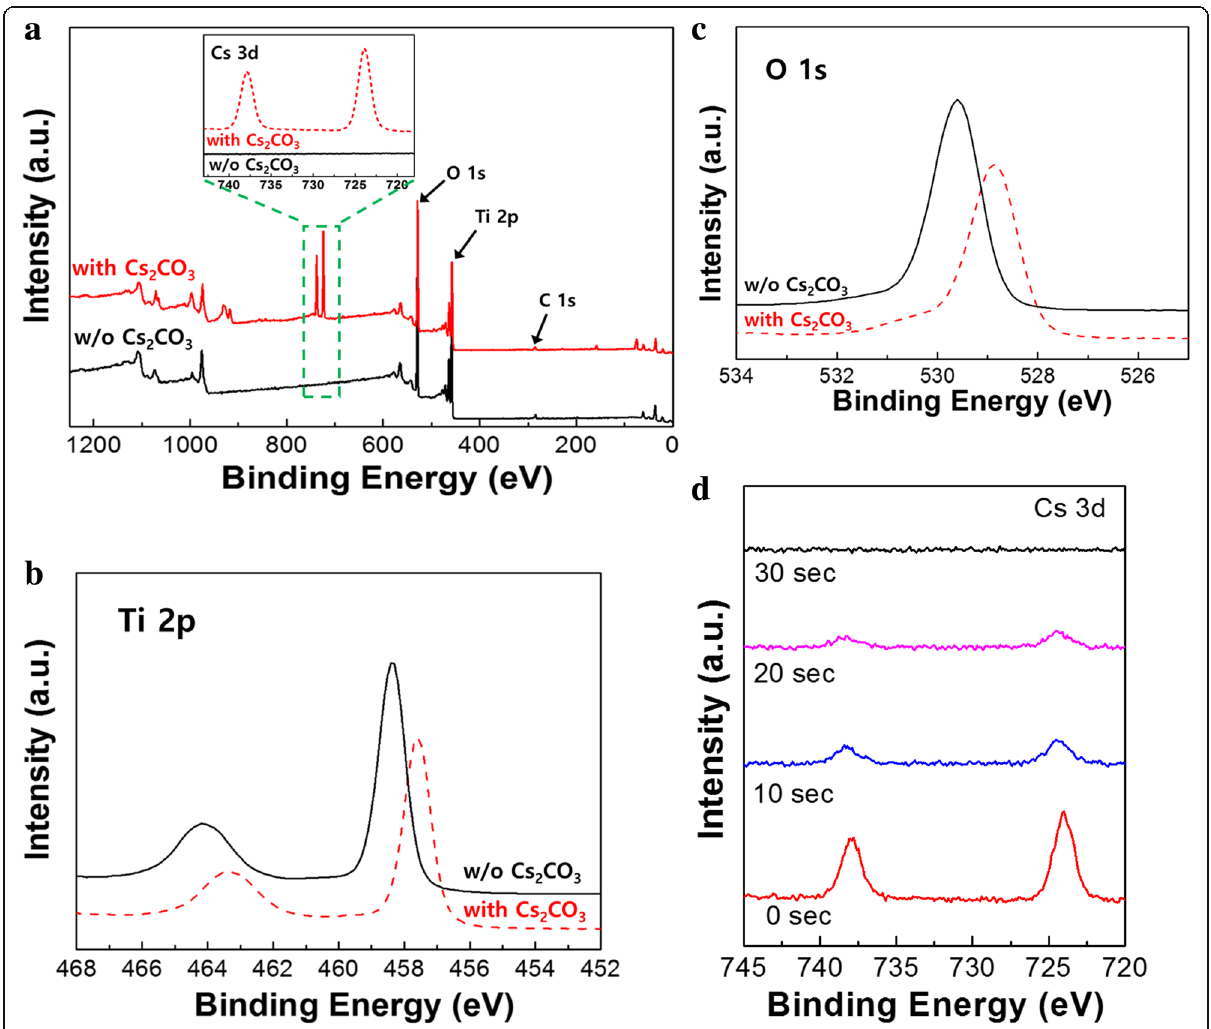
Fig. 5 XPS spectra of a survey scan and Cs 3d peak, b Ti 2p peak, c O 1 s peak for c-TiO 2 surface with and without Cs 2 CO 3 treatment, and d depth profile for Cs 3d peak for FTO/c-TiO 2 /Cs 2 CO 3 sample to determine the thickness of Cs-related